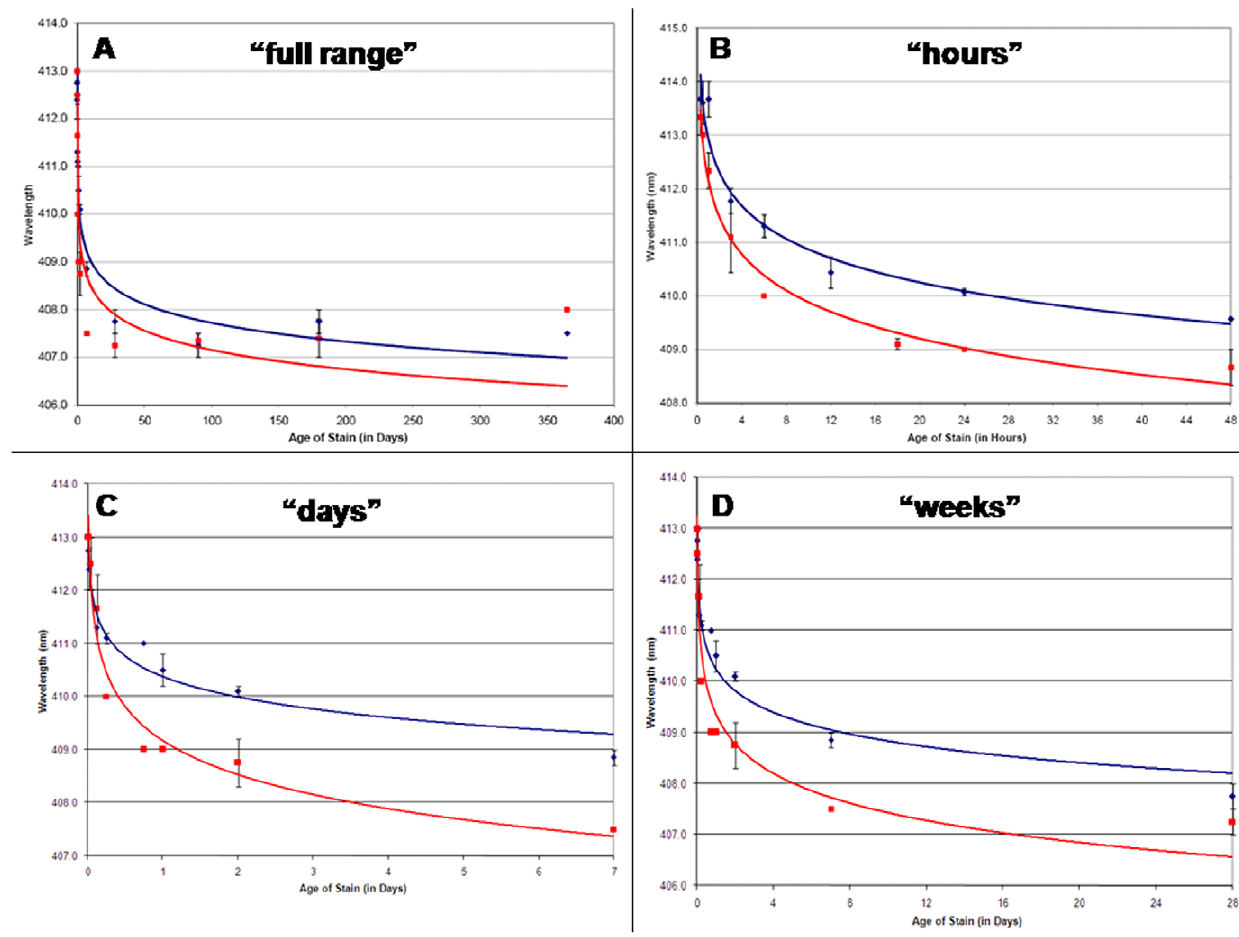
Figure 2. Bloodstain age (TSD) correlates with a blue shift of the Hb Soret band. Spectral profiles (350–600 nm) were obtained from samples stored at 22 u C (blue diamonds) and 37 u C (red squares) for 15 minutes to 1 year. The l max Soret is plotted as a function of stain age: A) ‘‘full range’’, 15 minutes –1 year (in days); B) ‘‘hours’’, 15 minutes –48 hours (in hours); C) ‘‘days’’, 15 minutes –7 days (in days); D). ‘‘weeks’’, 15 minutes –1 month (in days) All data points are an average of bloodstains from two biological replicates (two individual donors). The value used for each of the two biological samples was obtained from the average of three technical replicates for each sample. Using a logarithmic regression function (22 u C – blue; 37 u C - red), a strong degree of correlation was observed (R 2 . 0.95 for most data sets) allowing for differentiation of deposited hours, days, weeks and months prior to collection and analysis. (For interpretation of the references to color in this figure legend, the reader is referred to the web version of the article).